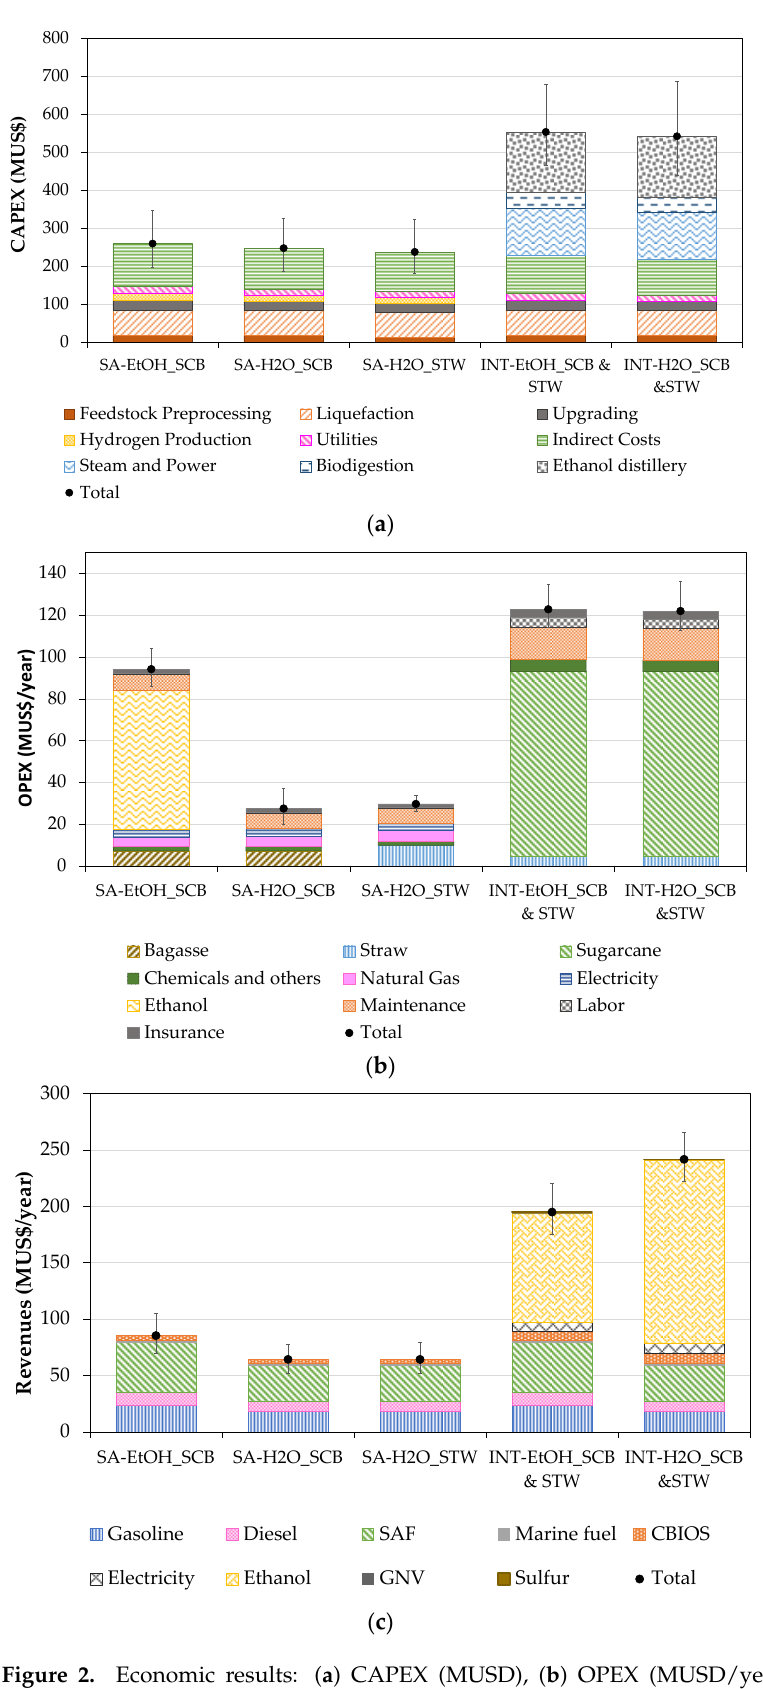
Figure 2. Economic results: ( a ) CAPEX (MUSD), ( b ) OPEX (MUSD/year), and ( c ) revenues